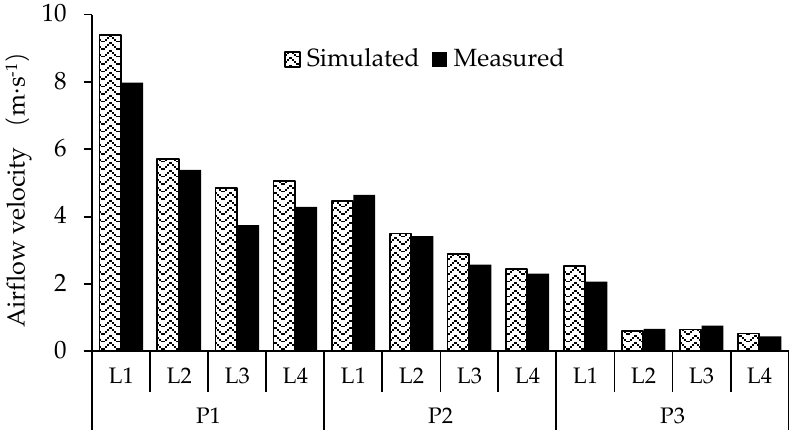
Figure 10. The distribution of air speed in canopy.